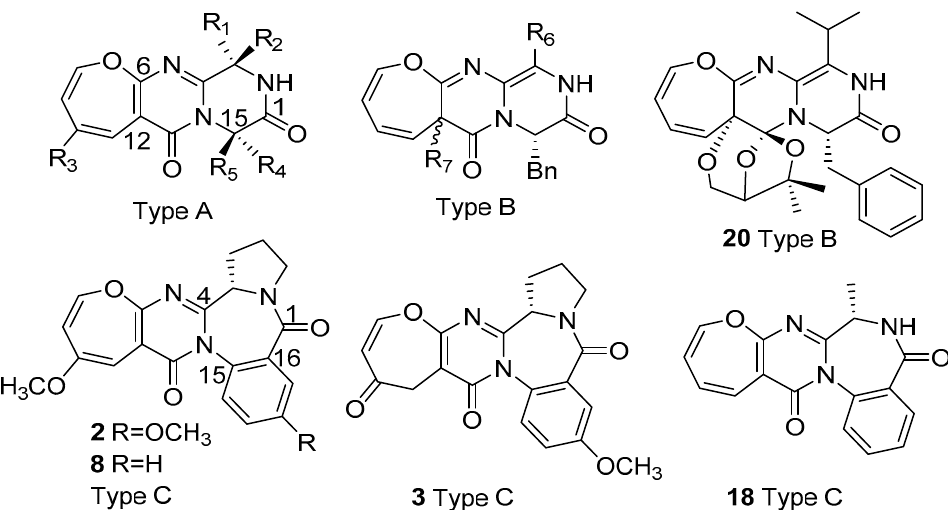
Figure 1. Structures of three types (A, B, and C) of Oxepine-Pyrimidinone-Ketopiperazine (OPK) nonribosomal peptides (NRPs).